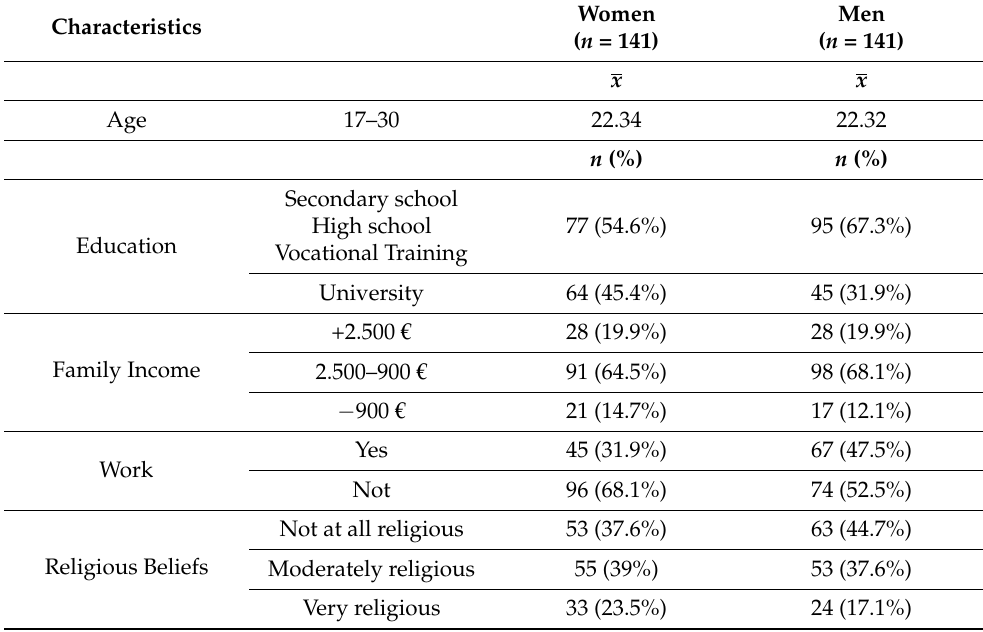
Table 1. Sociodemographic characteristics of the